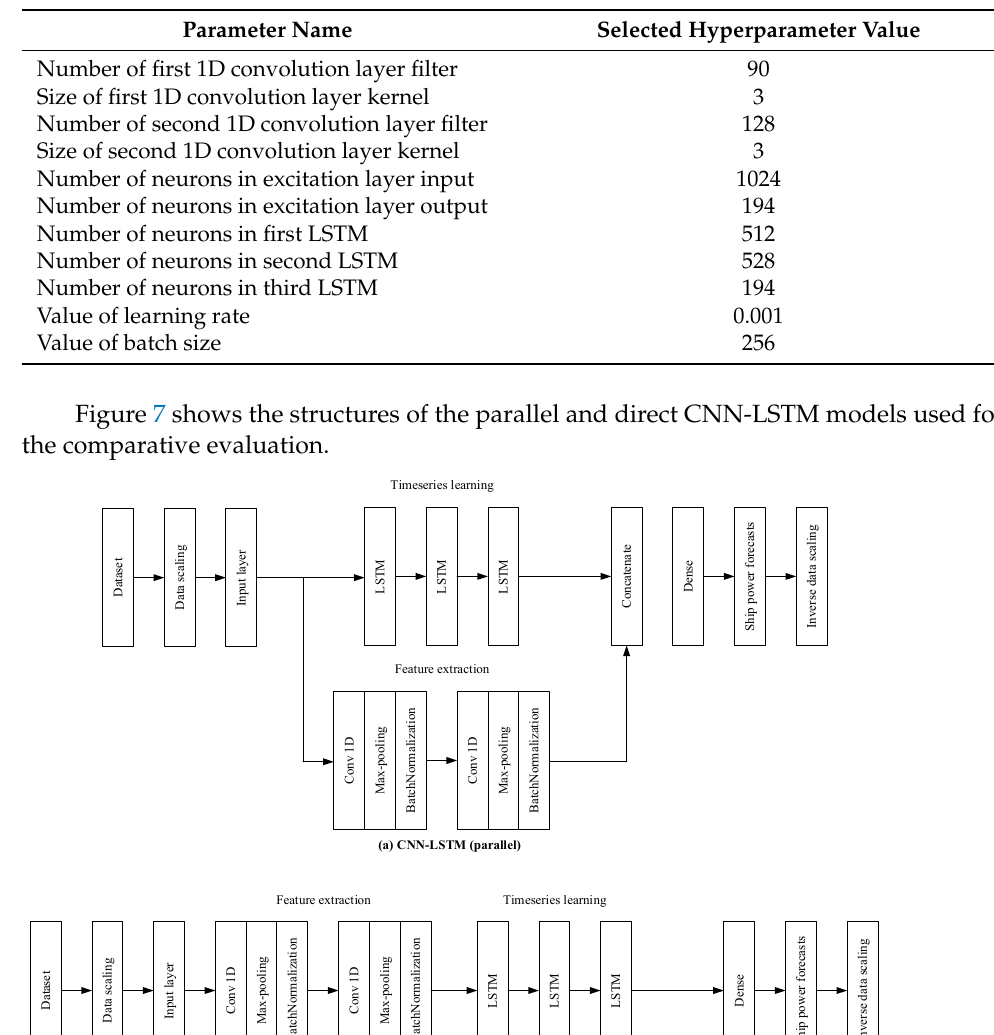
Table 4. Selected optimized hyperparameters of the proposed CNN-LSTM with the SE model by Bayesian optimization.